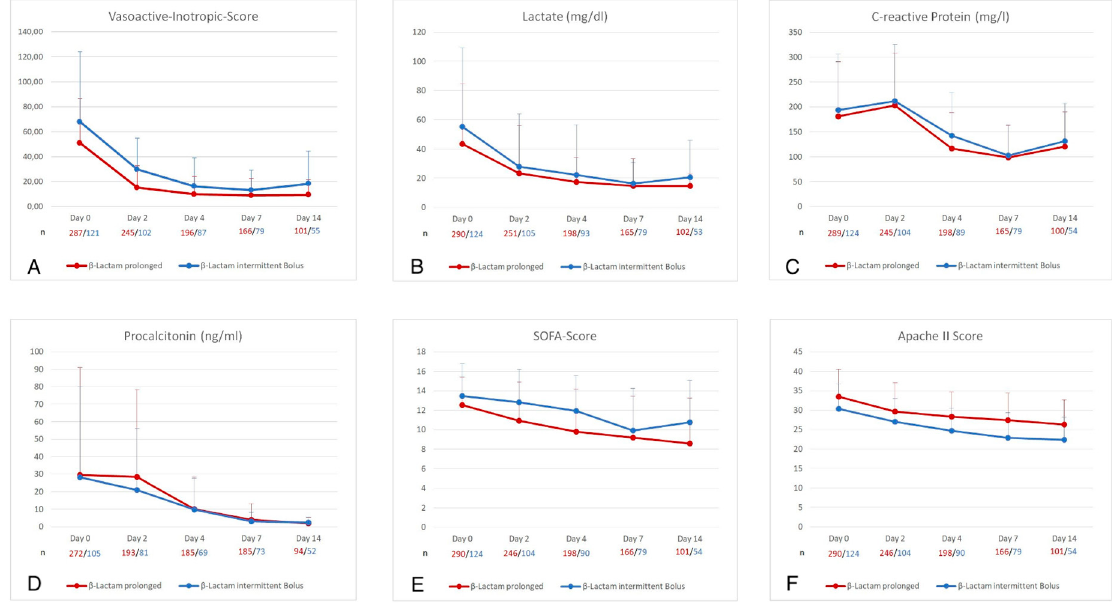
Figure 4. Course of Vasoactive-inotropic-score ( A ), Lactate ( B ), C-reactive protein ( C ), Procalcitonin ( D ), SOFA-Score ( E ), APACHE II Score ( F ) in baseline cohort over a 14 day observation